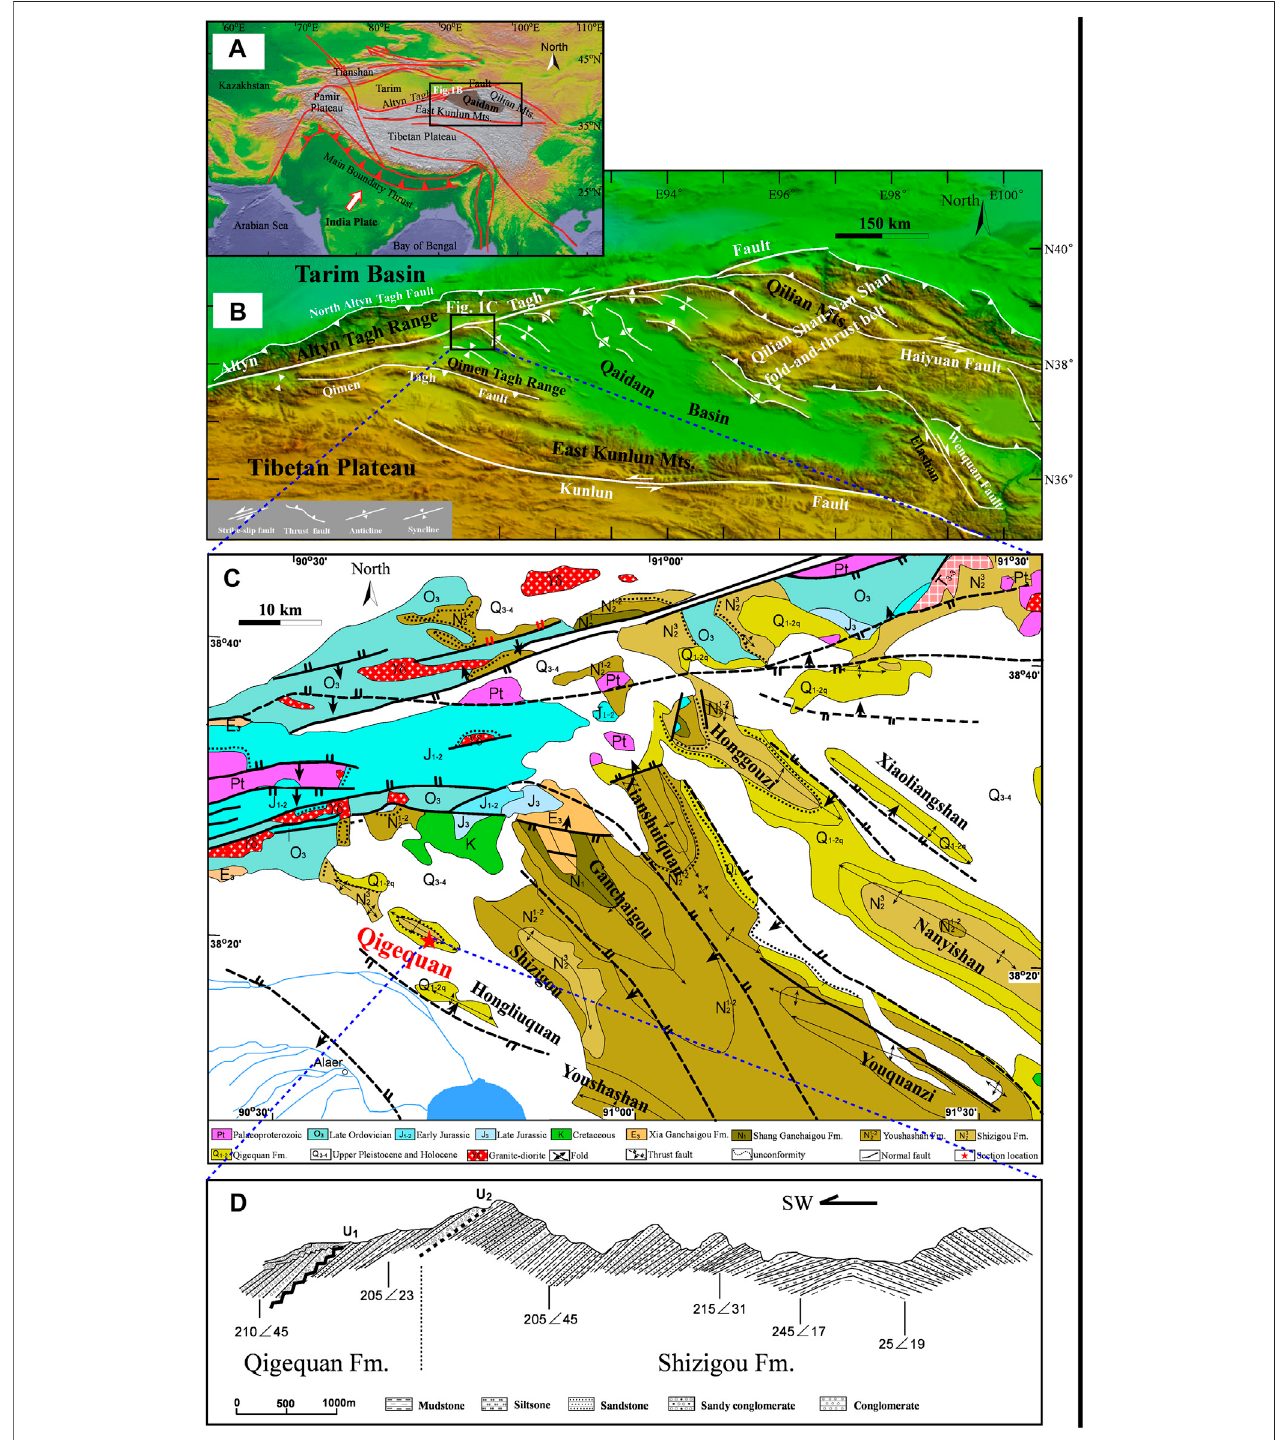
FIGURE1|(A) Tectonicdigitalelevationmodel(DEM)mapoftheTibetanPlateauanditadjacentregionsshowingthemajorthrustfaults[modi fi edfromSunJ.etal. (2005)]. (B) DEMmapofthenortheasternregionoftheNETibetanPlateaushowingthelocationsoftheQaidamBasin[modi fi edfromLietal.(2017)].SeePanel (A) forits geological area. (C) Geological map of the western Qaidam Basin showing the location of the Qigequan pro fi le (red pentagram). See Panel (B) for its location in the Qaidam Basin. (D) Cross-section along the Qigequan section. (B,C) are modi fi ed from Zhang et al. (2013).